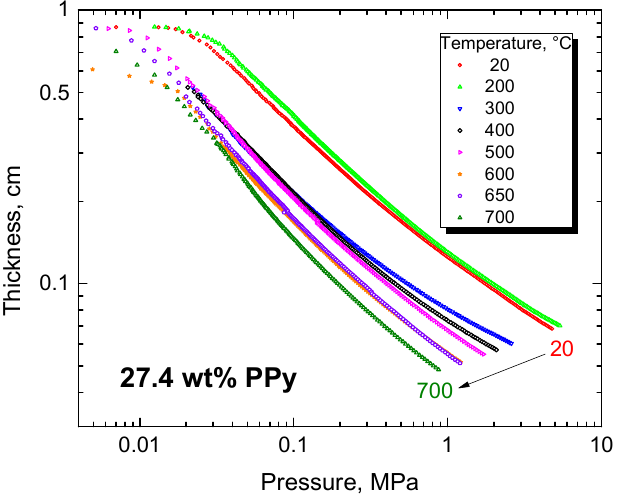
Figure 10. Dependence of the sample thickness on the applied pressure for polypyrrole-coated sponges after exposure to elevated temperatures.